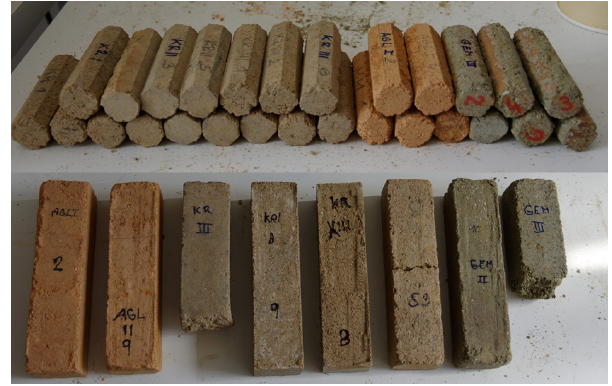
Figure 5. Different type of used clay in specimens.